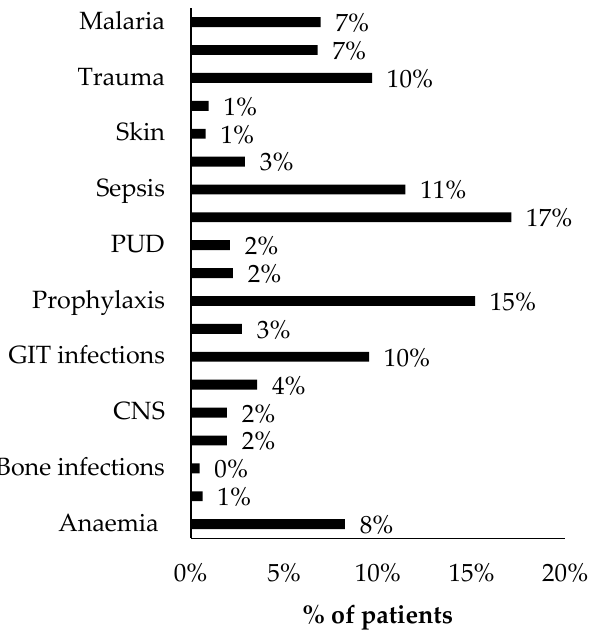
Figure 2. Indications for which ceftriaxone was prescribed in the nine health facilities ( n = 622). UTIs—urinary tract infections, STIs—sexually transmitted infections, RTIs—respiratory tract infections, PUD—peptic ulcer diseases, PTB—pulmonary tuberculosis, CNS—central nervous system conditions. Table 3. Completion proportions of the different doses of ceftriaxone prescribed. Dose Completion